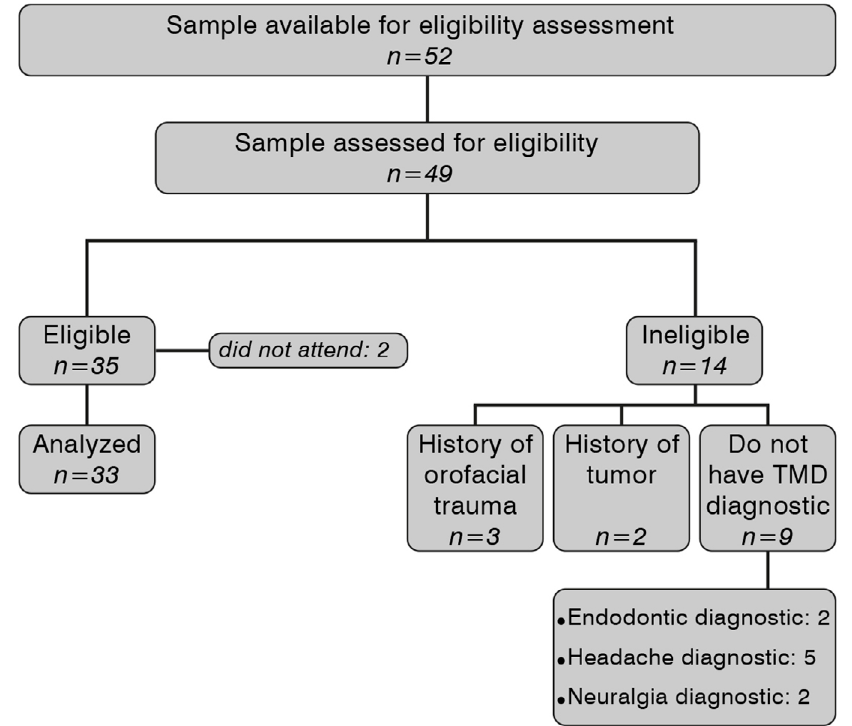
Figure 1- Flowchart of sample selection steps, following the inclusion and exclusion criteria; eligible and non-eligible volunteers and losses incurred for various